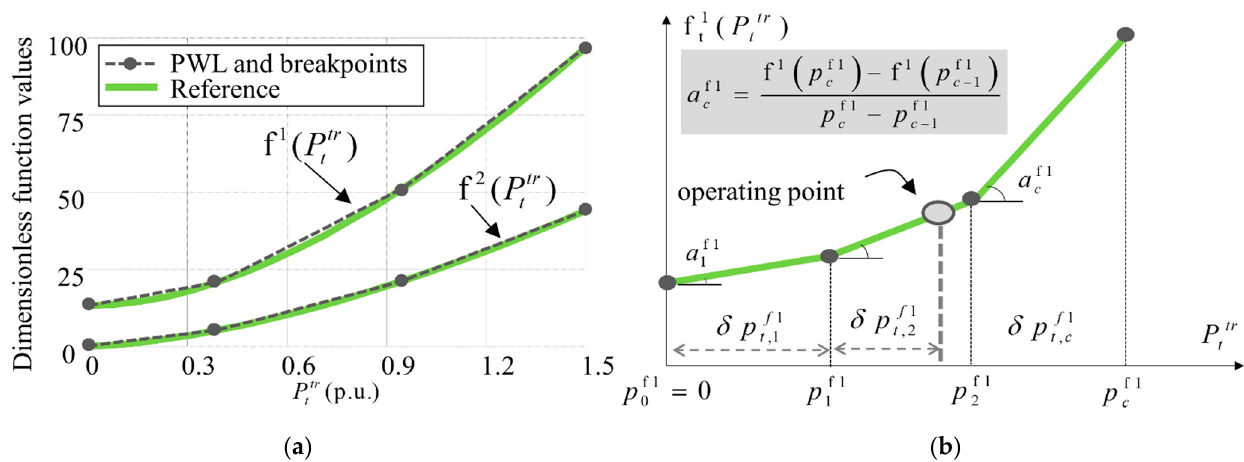
Figure 6. Piece - wise linearization (PWL) process: ( a ) functions fitting and breakpoints; ( b ) mathematical formulation for function f 1 .